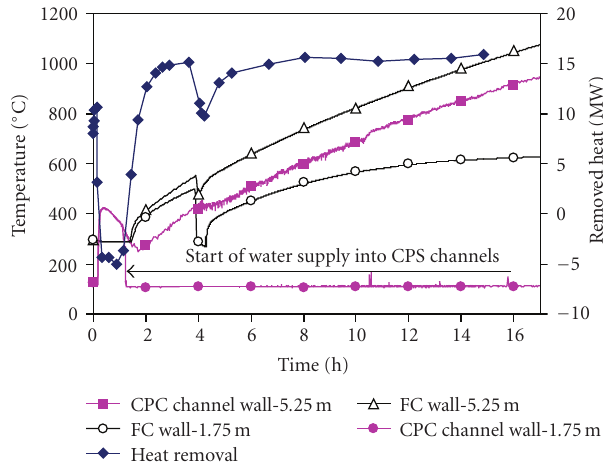
Figure 10: Station blackout case. Heat removal using CPS channels is taken into account. Behaviour of core components temperatures.